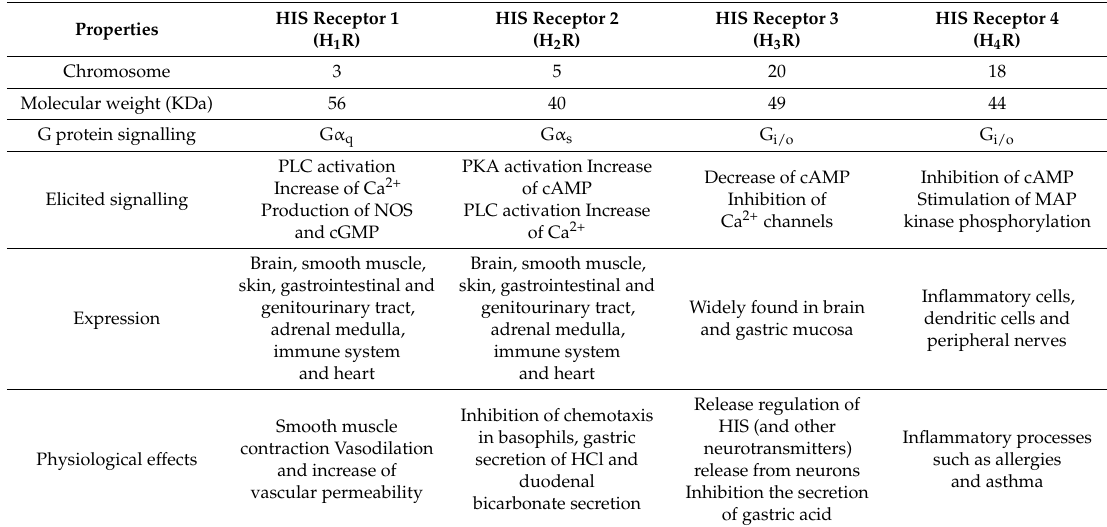
Table 2. Molecular and functional properties of human histamine receptor